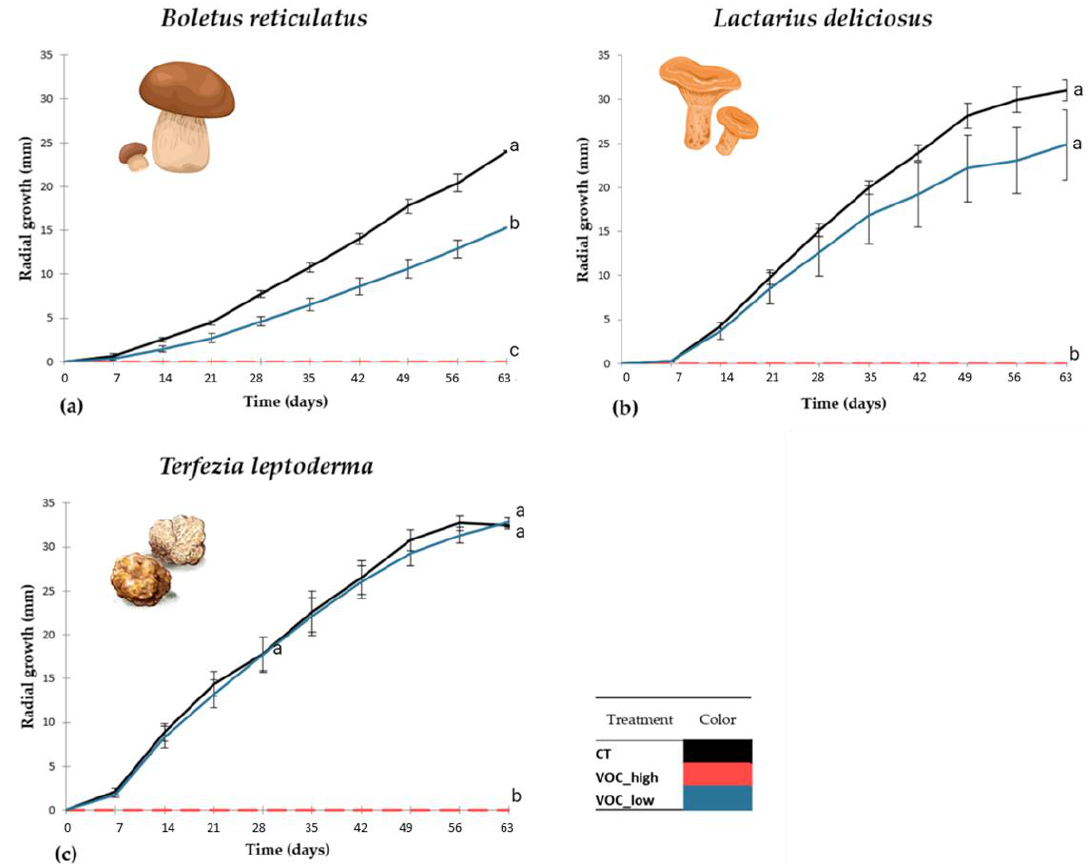
Figure 3. Effects of the 1-octen-3-ol doses on mycelium growth of Boletus reticulatus , Lactarius deliciosus and Terfezia leptoderma (N = 10). ( a ) Mycelium growth of B. reticulatus ; ( b ) mycelium growth of L. deliciosus ; ( c ) mycelium growth of T. leptoderma , measured over 63 days. Treatments: CT — black line; VOC_high — red line; VOC_low — blue line. Data were compared using a Kruskall – Wallis test. Post hoc comparisons were made using a Dunn ’ s test. Data are mean ± standard error. Different letters show significant differences ( p < 0.05) between treatments for each ECM fungus.